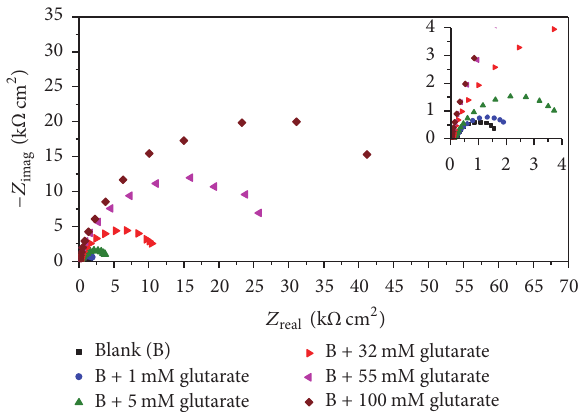
Figure 2: Typical Nyquist diagrams for carbon steel in the 0.02 M NaCl solution without (blank) and with additions of sodium